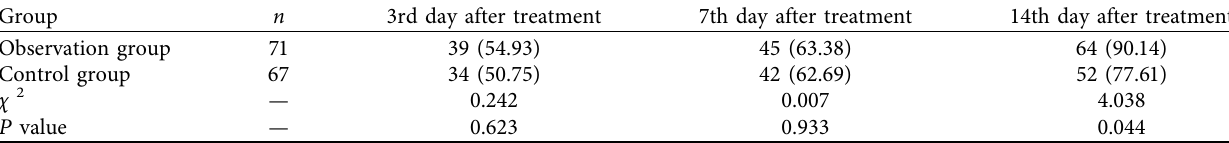
Table 3: Comparison of bacterial clearance rates between the two groups on the 3rd, 7th, and 14th days after treatment ( n , %).